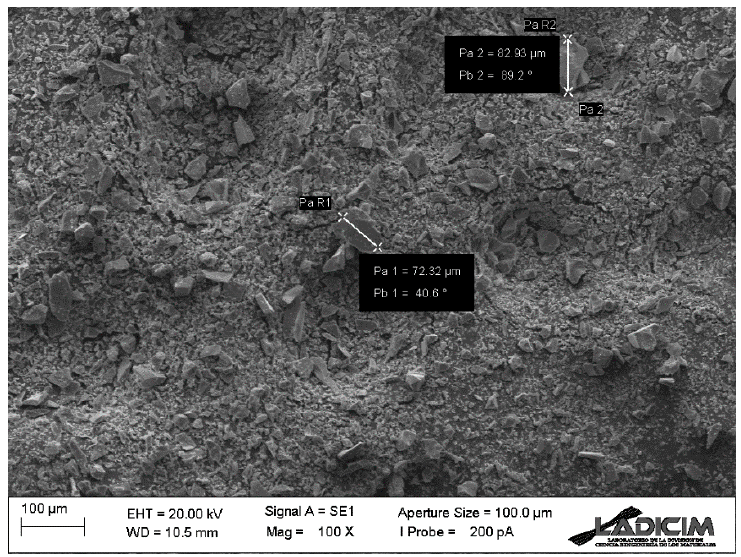
Figure 3. Determination of the maximum particle size of cupola slag by SEM.